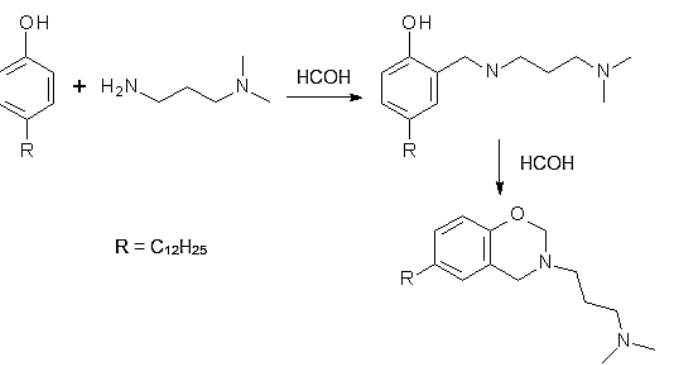
Figure 3. Scheme of the 6-dodecyl-3-(N,N-dimethylaminopropyl)-3,4-dihydro-2H-[1,3]-benzoxazine (DEM1) synthesis reaction.